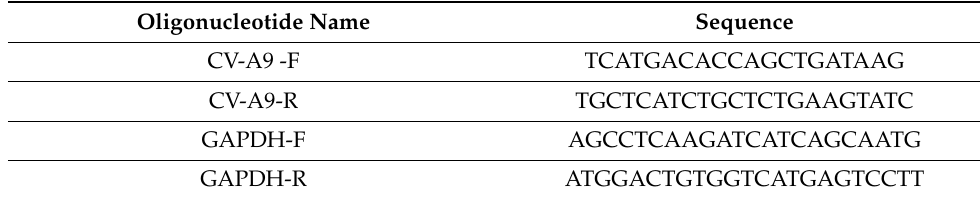
Table 2. Oligonucleotides used in the study. Oligonucleotide